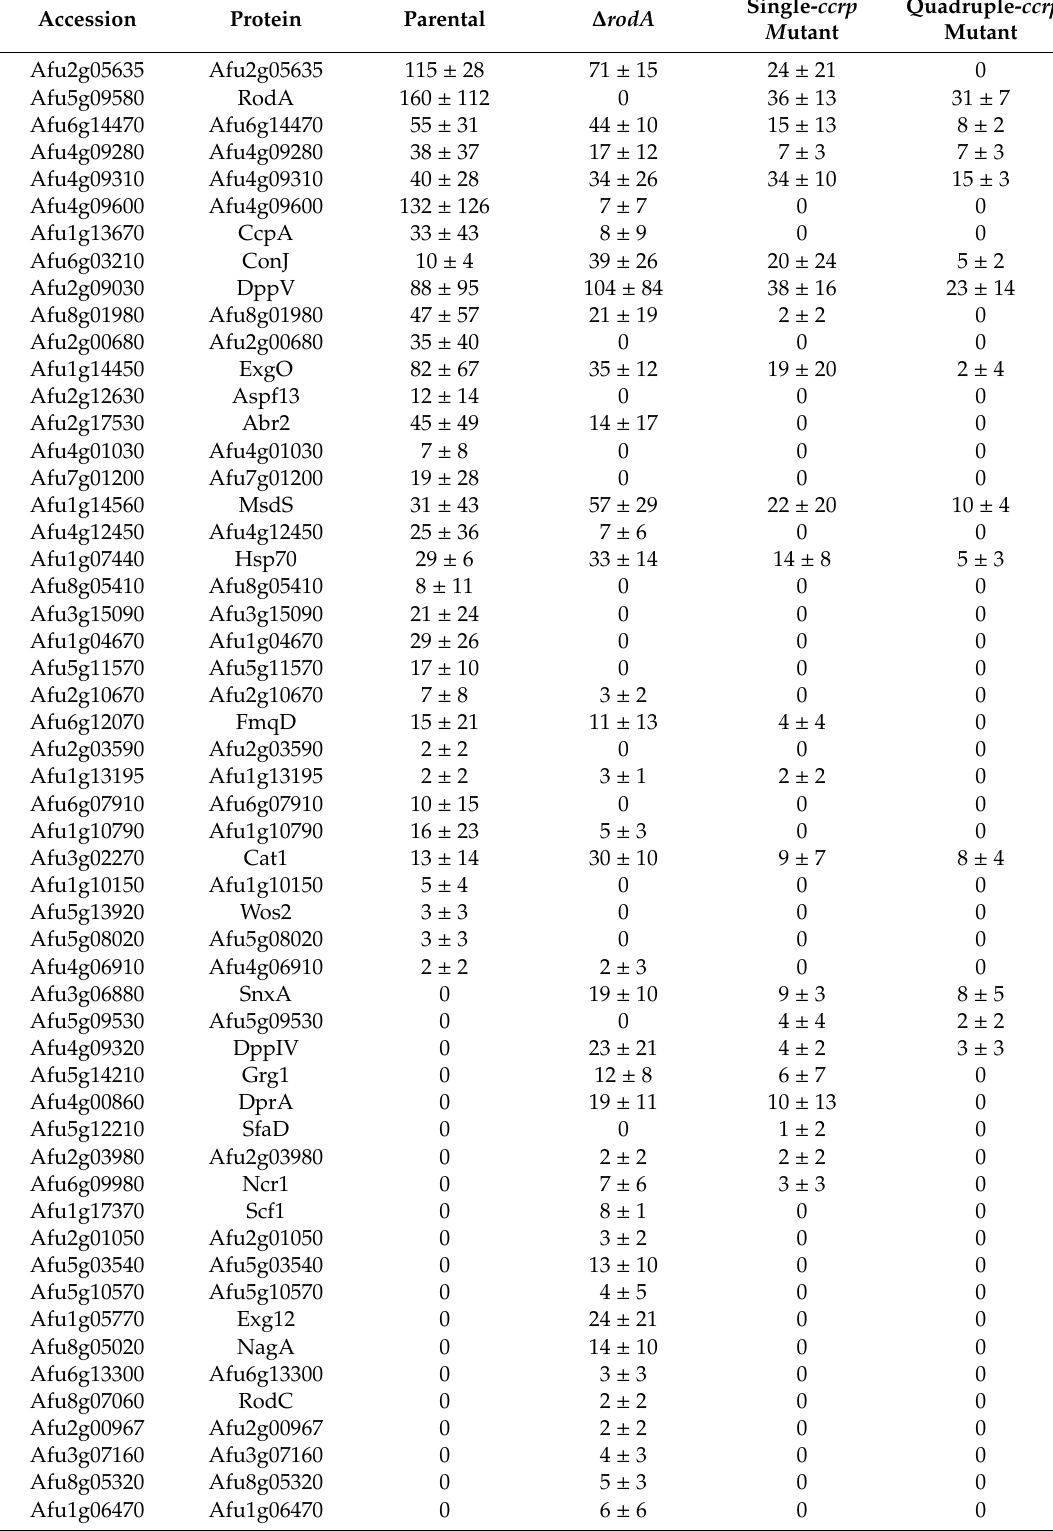
Table A1. Peptide-spectrum match scores (PSM; the total number of identified peptide spectra matched for a protein) of the conidial surface proteins extracted after trypsin